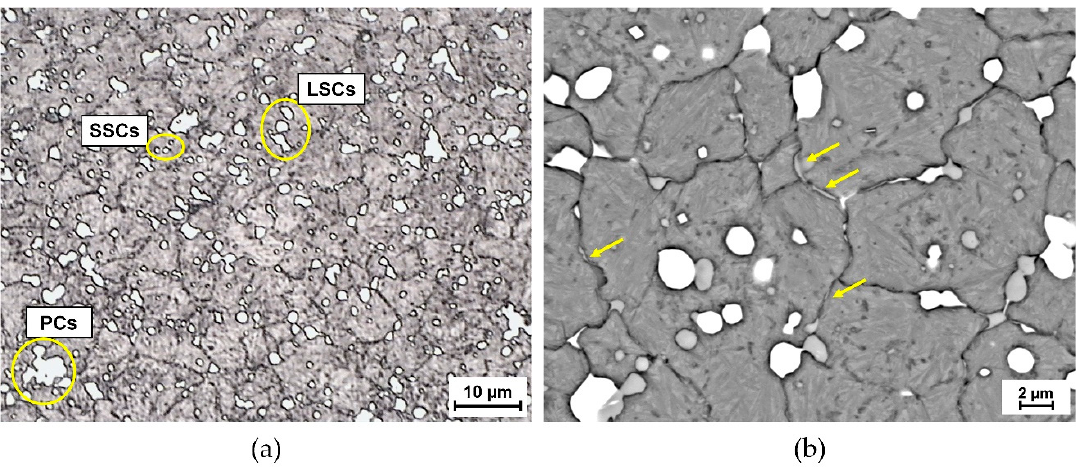
Figure 3. ( a ) Optical and ( b ) BSE-SEM micrographs of the microstructure observed on the cross-section of taps after CHT_5. Yellow circles in ( a ) indicate primary carbides (PCs), large secondary carbides (LSCs) and small secondary carbides (SSCs). Yellow arrows in ( b ) show the semi-continuous distribution of proeutectoid carbides visible along prior austenitic grain boundaries.